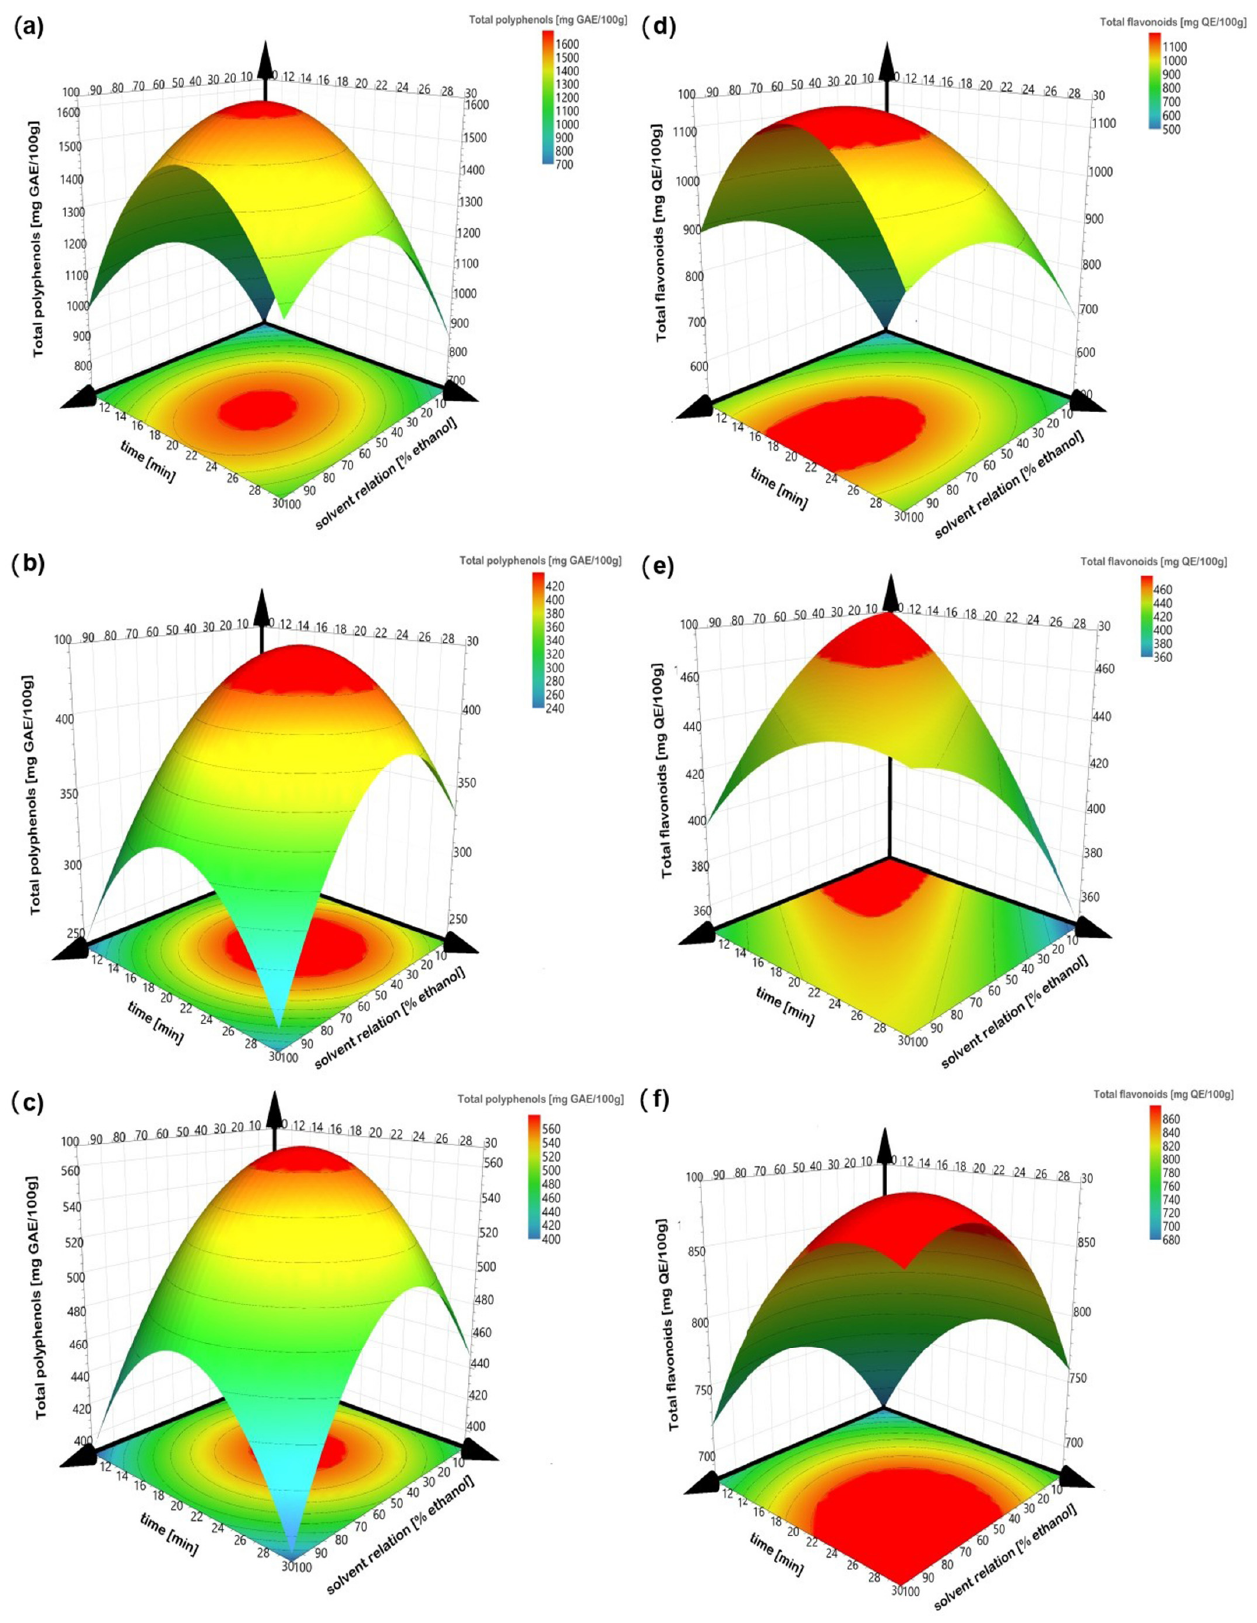
Figure 2. Response surface of total polyphenols (left) and total flavonoids (right). ( a , d ) peel; ( b , e ) endocarp and ( c , f ) kernel.